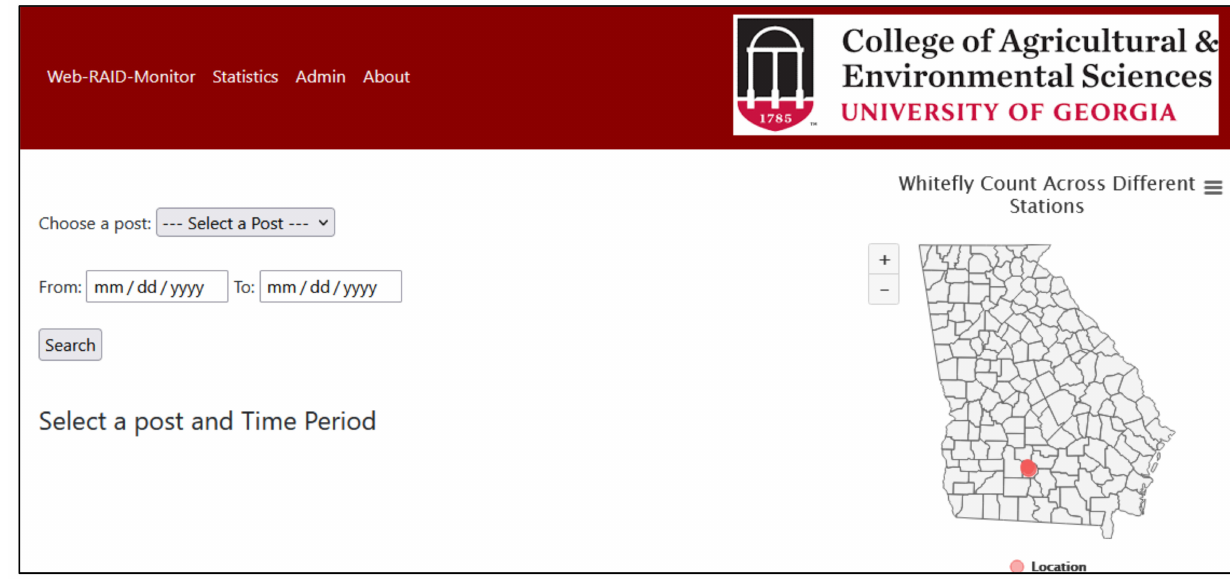
Figure 8. Web-Raid Monitor System